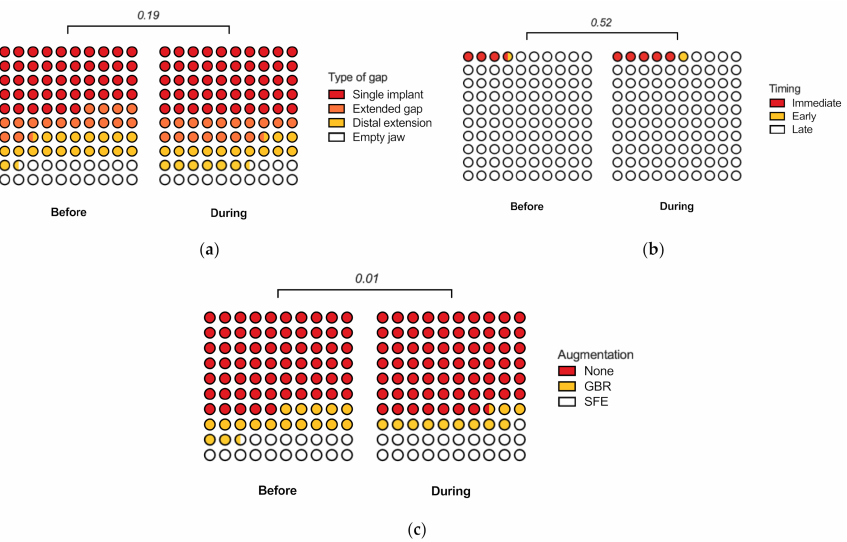
Figure 3. Implant parameters. ( a ) Type of edentulous space. ( b ) Timing of implant placement. Immediate implant placement took place in the same surgery as tooth extraction. Early implant placement took place no later than 8 weeks following tooth extraction. ( c ) Bone augmentation. GBR — guided bone regeneration; SFE —sinus floor elevation. All p -values using the Chi-squared test with the Holm-Sidak correction for multiple